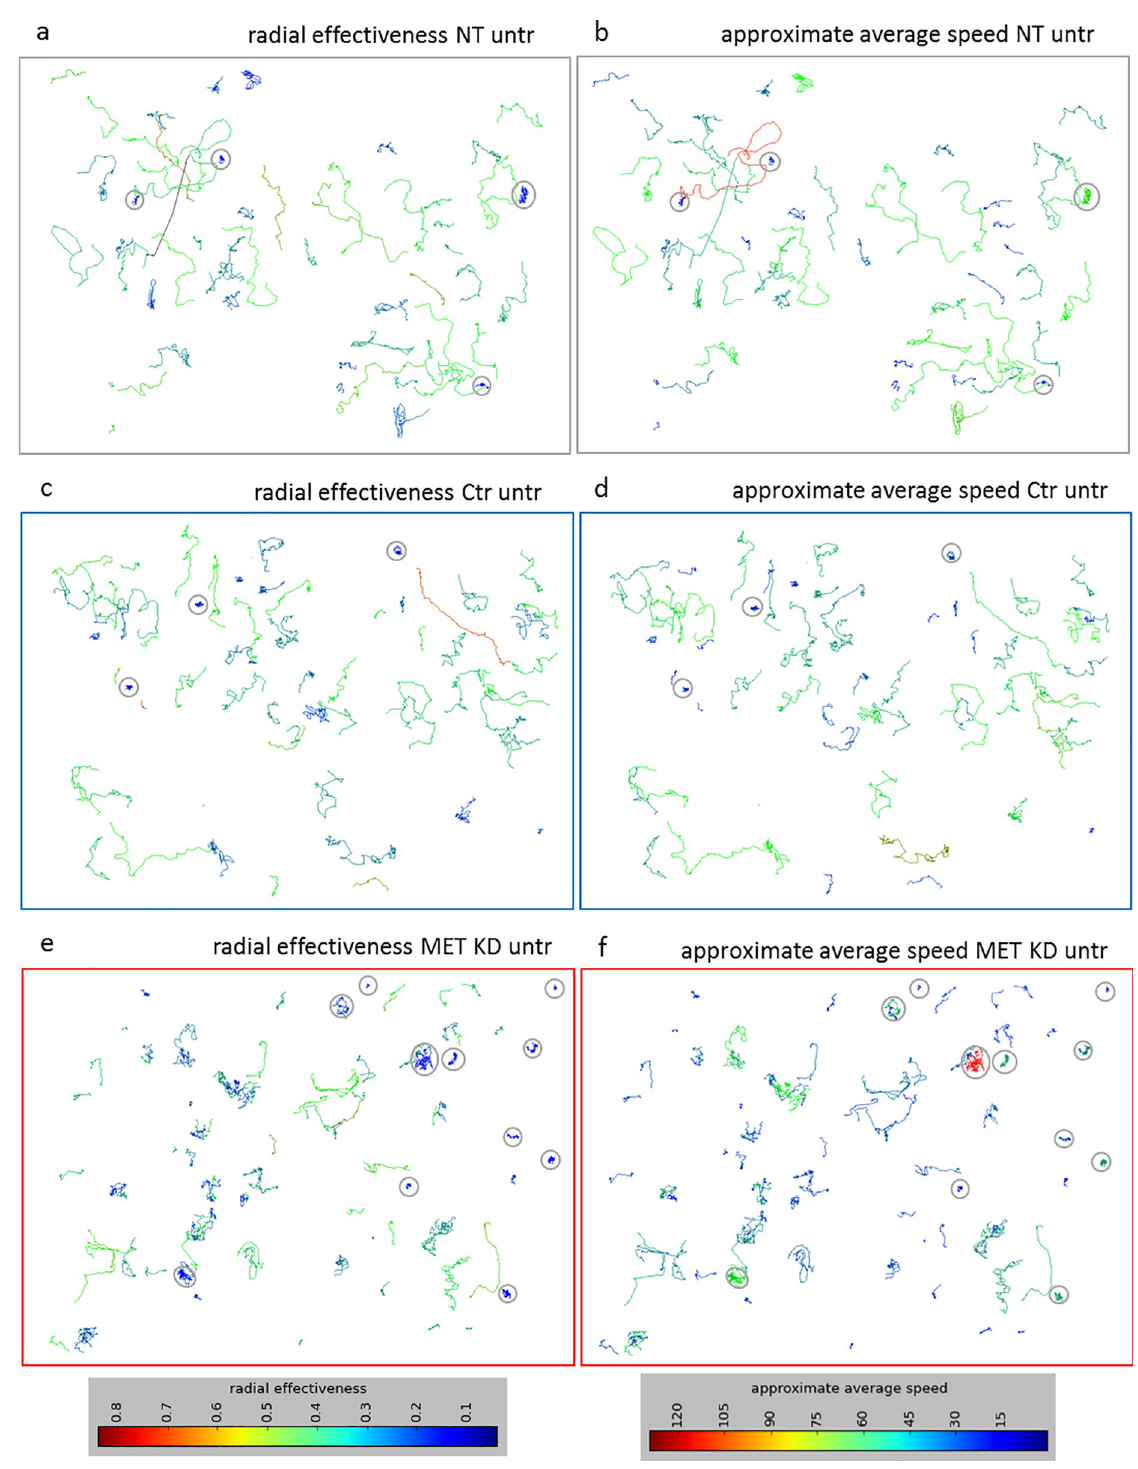
Fig 9. MET knockdown increases proportion of cells with low radial effectiveness but medium approximate average speed. Hs746T cells were transfected with MET siRNA (MET KD) or control siRNA (Ctr). Non-transfected cells (NT) were analyzed as control. Time-lapse microscopy was started one day after transfection. Cell movement was tracked for 7 hours to assess radial effectiveness and approximate average speed. The trajectories of one exemplary film for each condition are shown. The trajectories were color-coded for radial effectiveness (panels a, c, d) or approximate average speed (panels b, d, f). The cells with lowest radial effectiveness ( < 0.1) were highlighted with grey